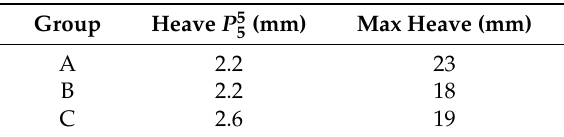
Figure 12. Exceedance plots for heave error ranges for Groups A, B, and C. Table 5. Heave P 5 values. The maximum values are the average of the peak heave values for the five repetitions in each group.